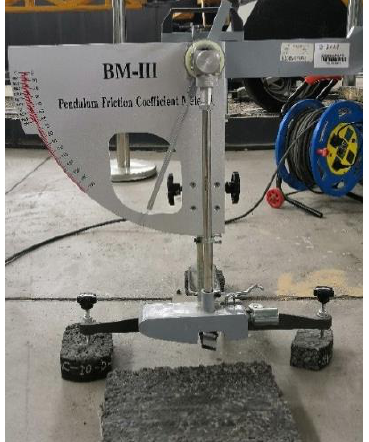
Figure 4. British Pendulum Tester.